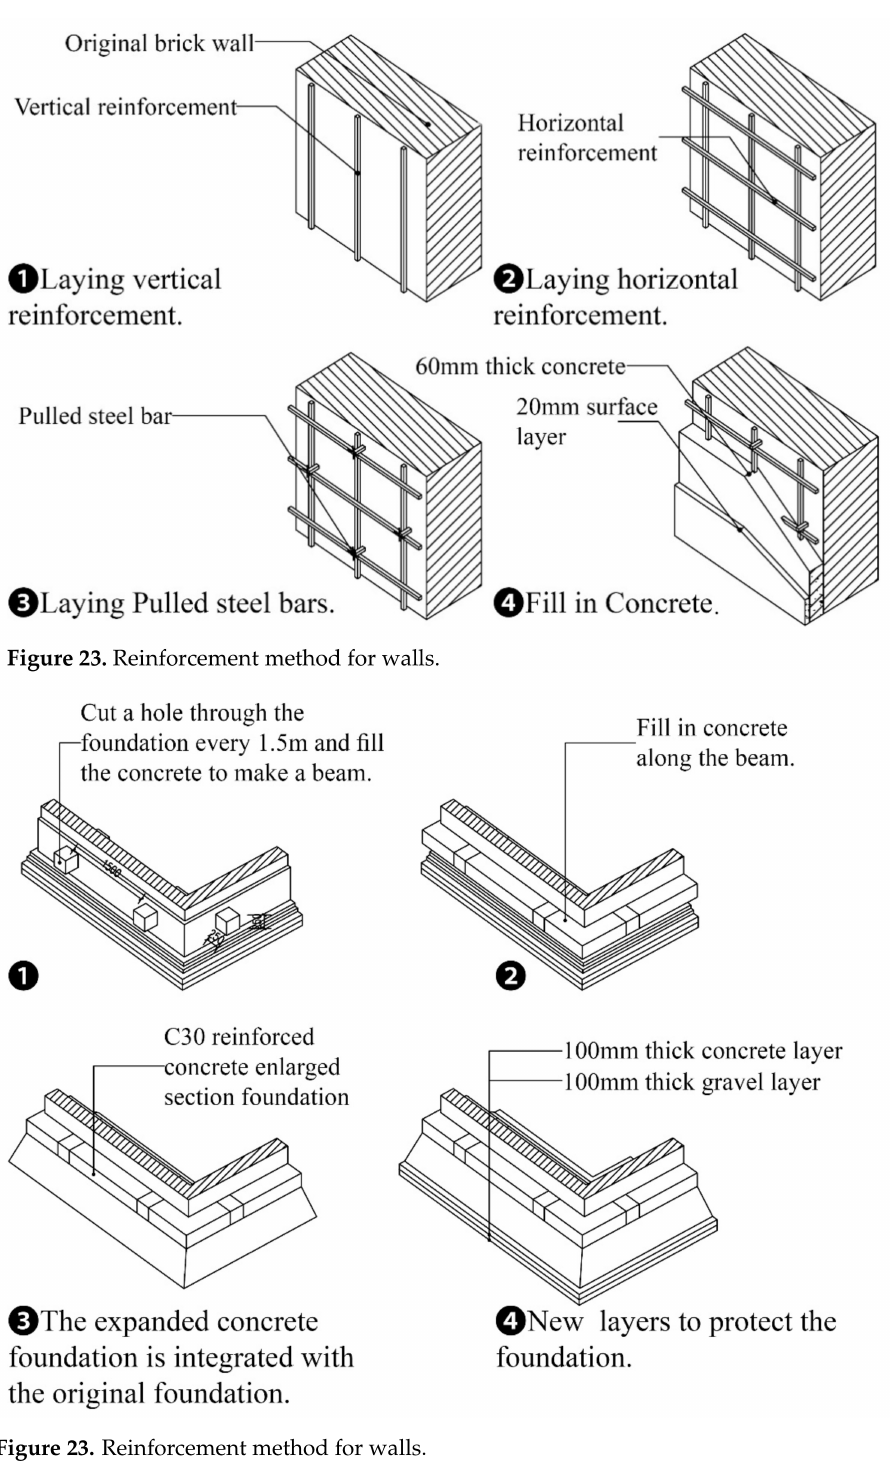
Figure 23. Reinforcement method for